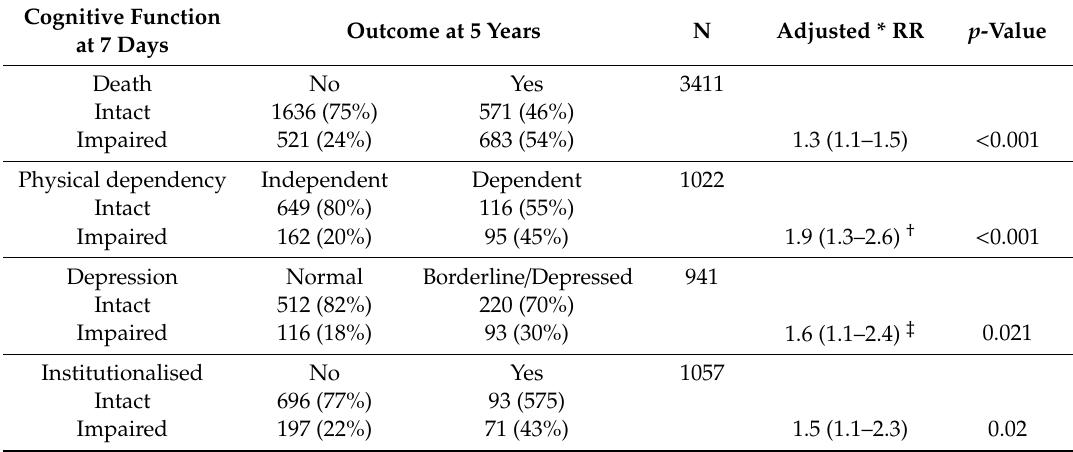
Table 3. Five year outcomes by seven day cognitive impairment.